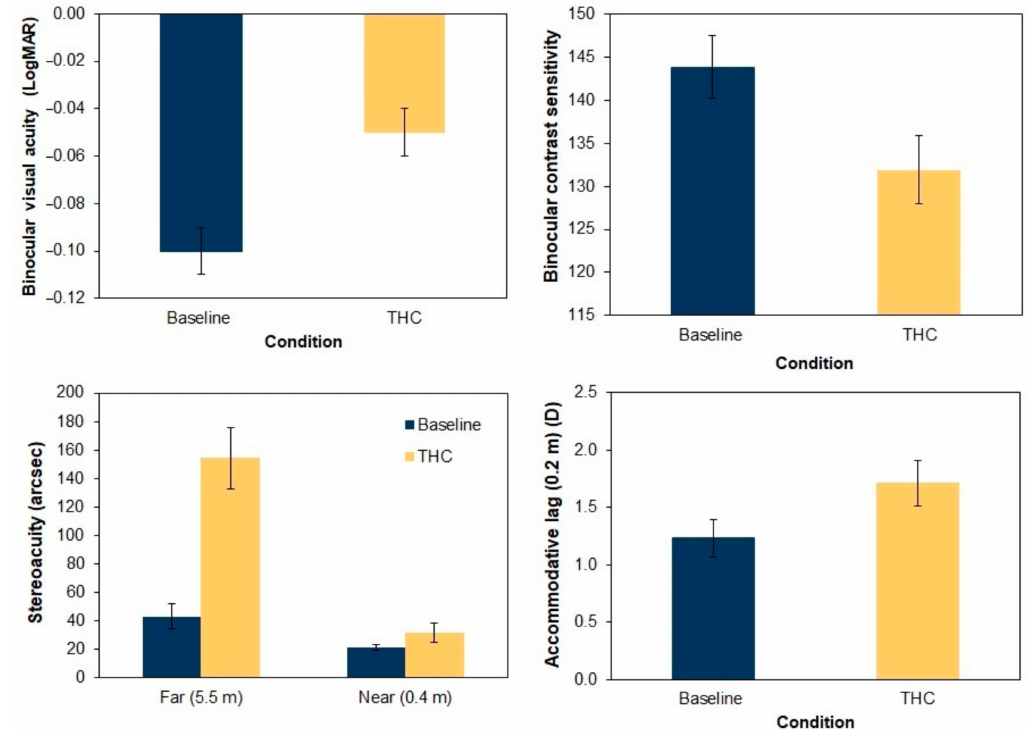
Figure 2. Results obtained for visual parameters that deteriorated significantly after smoking cannabis ( p <